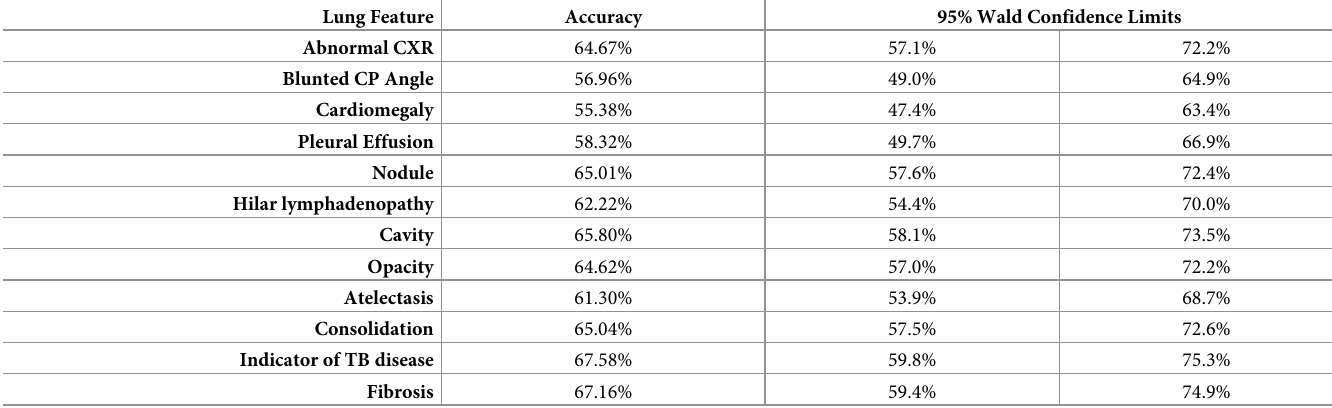
Table 12. Qure.ai classifier score predicting TBPP outcome died; receiver operating characteristic statistics